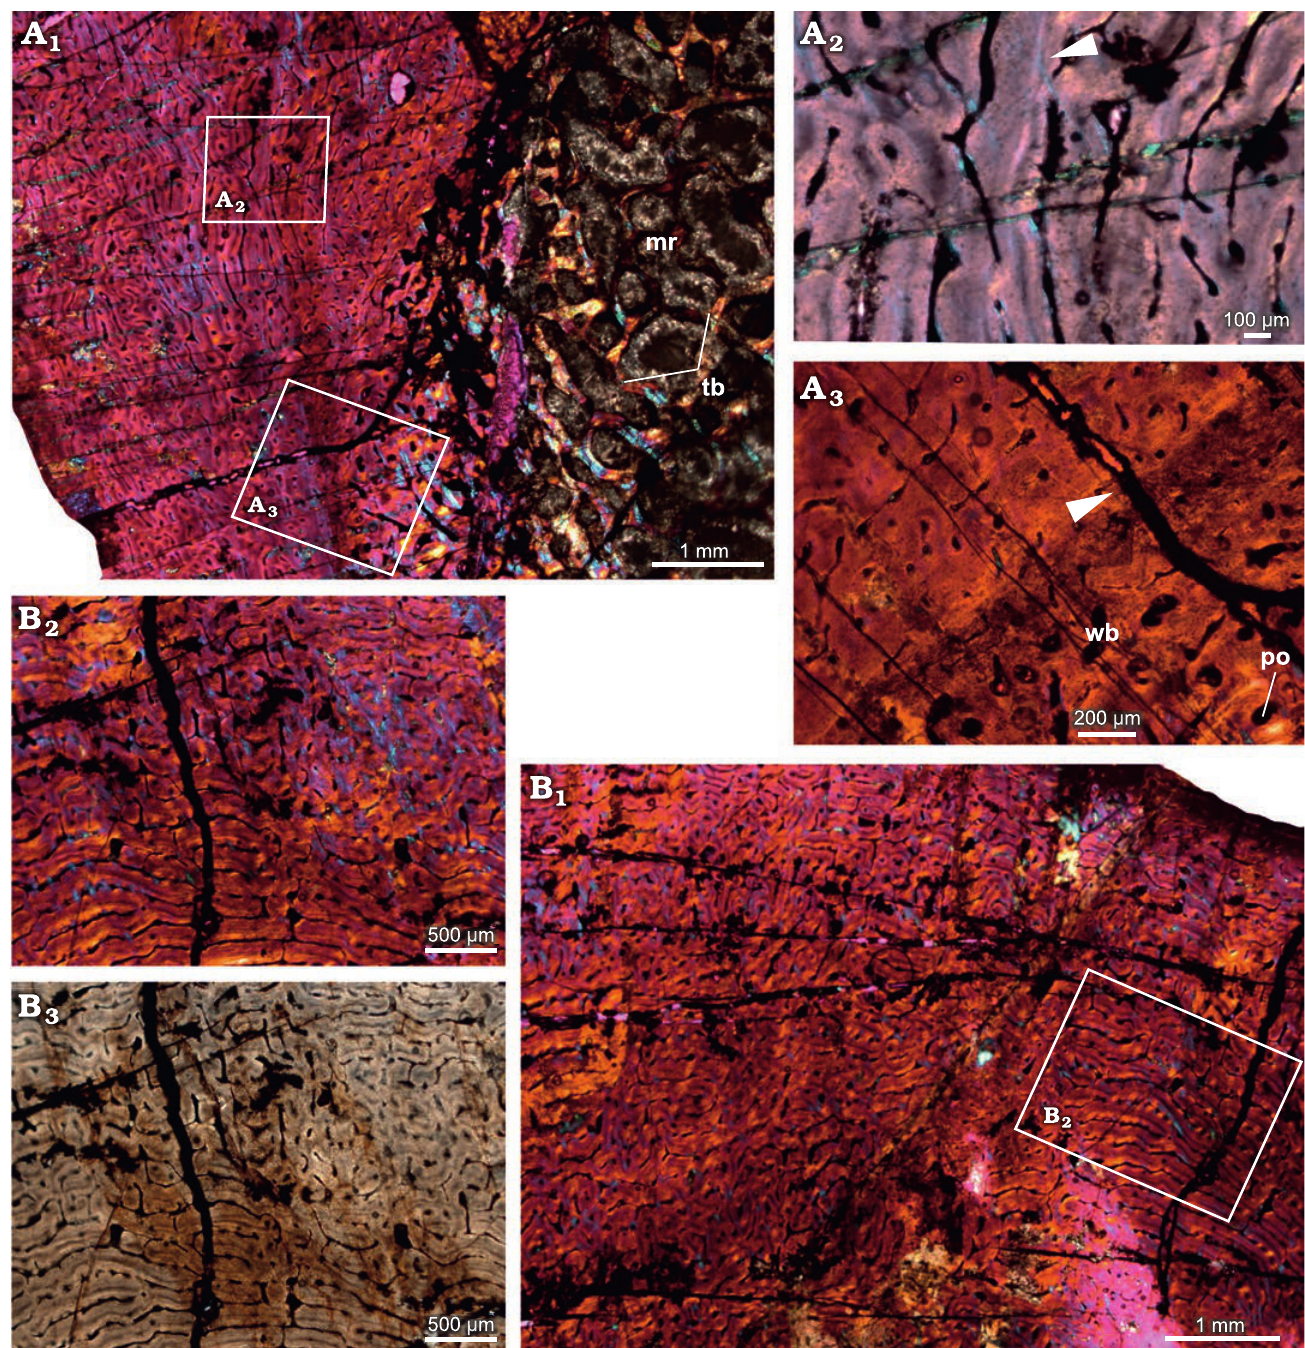
Fig. 2. Transverse sections of the radius (SAM-PK-12233b) of Jonkeria parva (Boonstra, 1955) from the middle Permian Tapinocephalus Assemblage Zone of the Karoo Basin of South Africa. A 1 , diaphyseal cross-section showing highly vascularized fibrolamellar bone tissue in the outer cortex and the medullary cavity filled with bony trabeculae; note: the numerous enlarged resorption cavities in the perimedullary region. A 2 , detail showing an annulus with lamellar bone (arrowhead). A 3 , detail showing extension of an annulus in the cortex (arrowhead). B 1 , fibrolamellar bone tissue with woven matrix in the outer cortex showing circumferential and reticular organization of the vascular canals; B 2 , B 3 , detail showing the change to a reticular organization of the vascular canals. Abbreviations: mr, medullary region; po, primary osteon; tb, trabeculae; wb, woven bone. Photographs under cross-polarized light with lambda compensator (A 1 –A 3 , B 1 , B 2 ) and ordinary light (B 3